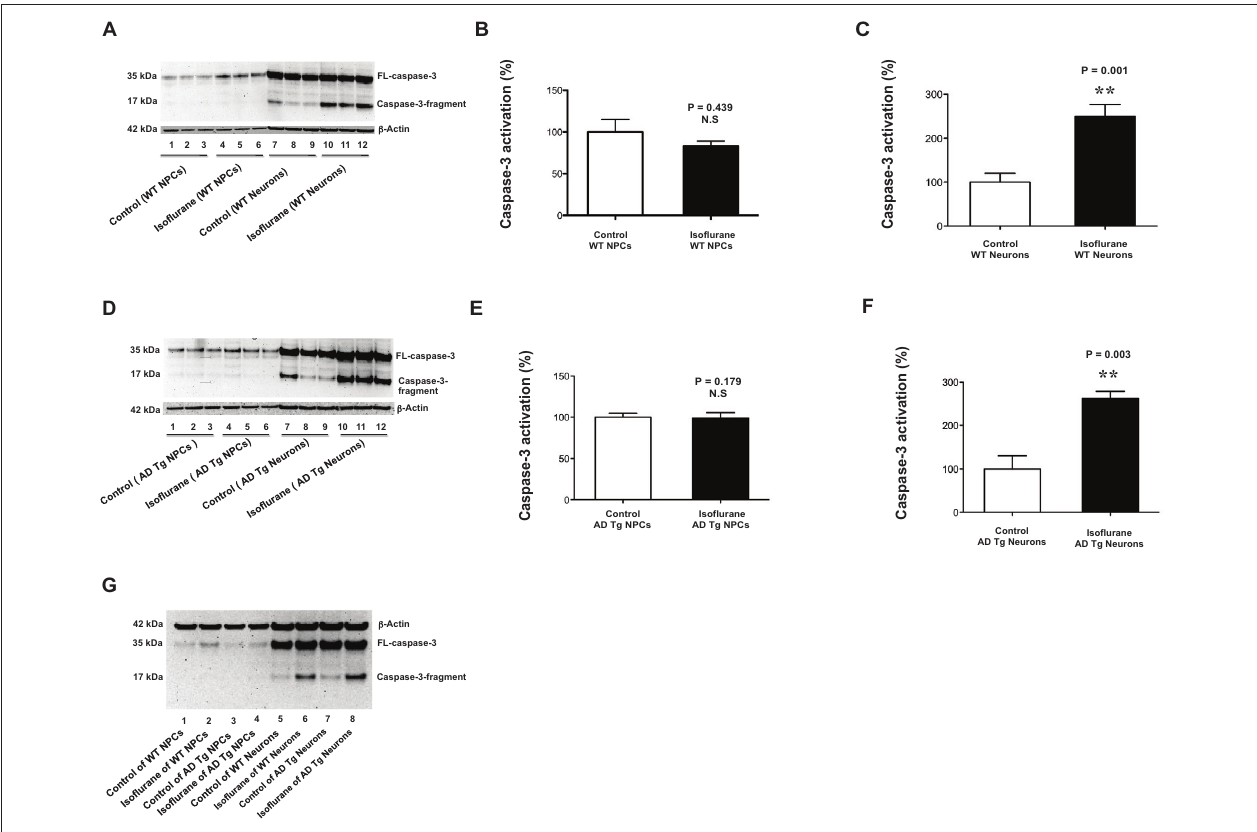
following the isoflurane treatment (lanes 10–12) as compared to that following control condition (lanes 7–9) in the AD Tg mice neurons. (E) The quantification of the Western blot shows that the isoflurane treatment (black bar) does not induce caspase-3 activation as compared to control condition (white bar) in the AD Tg mice NPCs. (F) The quantification of the Western blot shows that the isoflurane treatment (black bar) induces caspase-3 activation as compared to the control condition (white bar) in AD Tg mice neurons. (G) There is a higher level of caspae-3 fragment following the isoflurane treatment (lane 6 or 8) than that following control condition (lane 5 or 7) in the WT or AD Tg mice neurons. The caspase-3 fragment level following the isoflurane treatment in the AD Tg mice neurons (lane 8) is greater than that in the WT mice neurons (lane 6). There is no visible difference in the levels of caspase-3 fragment between control condition and isoflurane treatment in the WT mice NPCs or AD Tg mice NPCs (lanes 1–4). NPCs, neural progenitor cells; AD, Alzheimer’s disease; Tg, transgenic; WT, wild type; full-length,